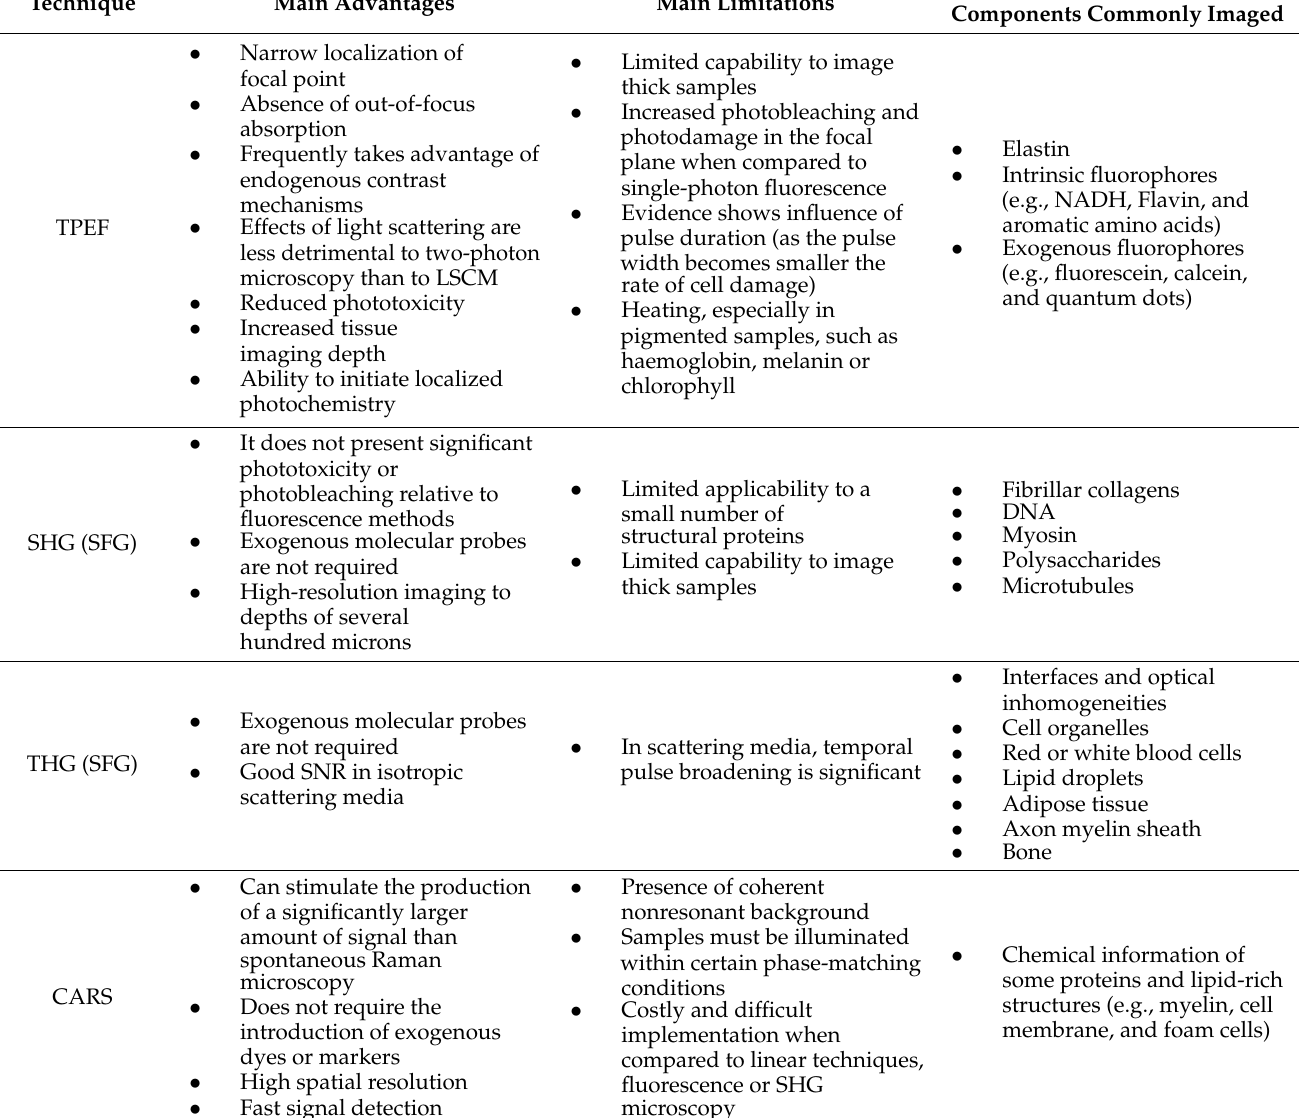
Table 3. The most commonly used nonlinear optical microscopy (NLOM)* modalities to assess ECM components. Technique Main